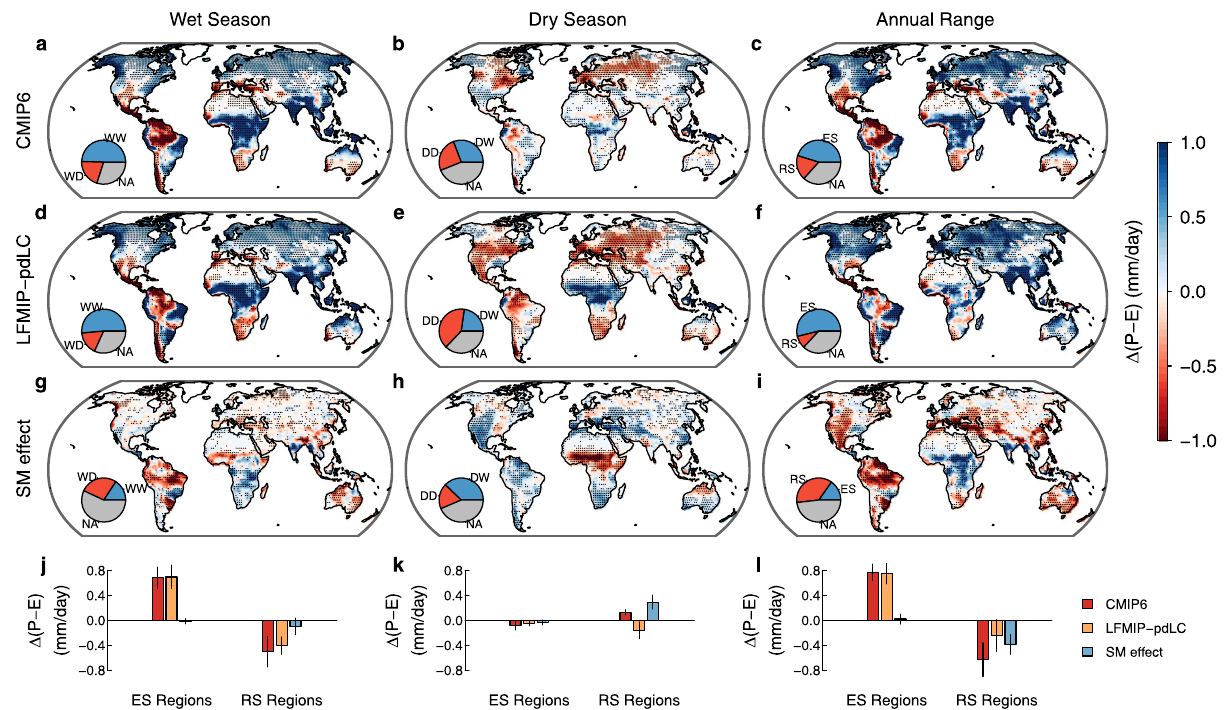
Fig. 3 | Soil moisture effectson water availability in the wet and dry seasonsin CMIP6. a – c Multi-model mean seasonal changes in water availability ( Δ (P-E)) between1980 – 2000(historicalsimulation)and 2080 – 2100(SSP585simulation)in the fi ve CMIP6 models which participate in the LFMIP-pdLC experiment. d – f The same as ( a – c ) but for Δ (P-E) in LFMIP-pdLC (without soil moisture effect). g – i Soil moisture (SM) effects on Δ (P-E) assessed as CMIP6 minus LFMIP-pdLC results.